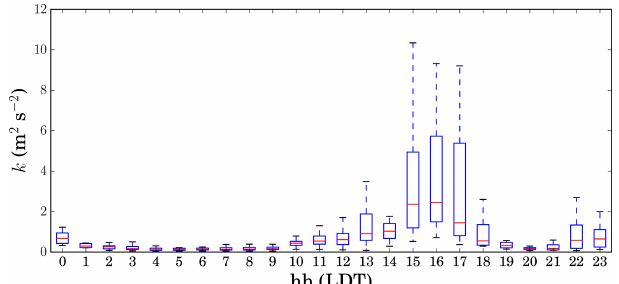
Figure 6. Diurnal variation of turbulence kinetic energy; at each hour, observations are plotted using statistical percentiles (5th, 25th, 50th, 75th, and 95th); times are in